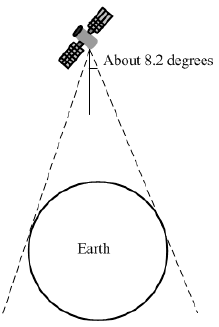
Figure 4. Geo-SAR instantaneous field of view.